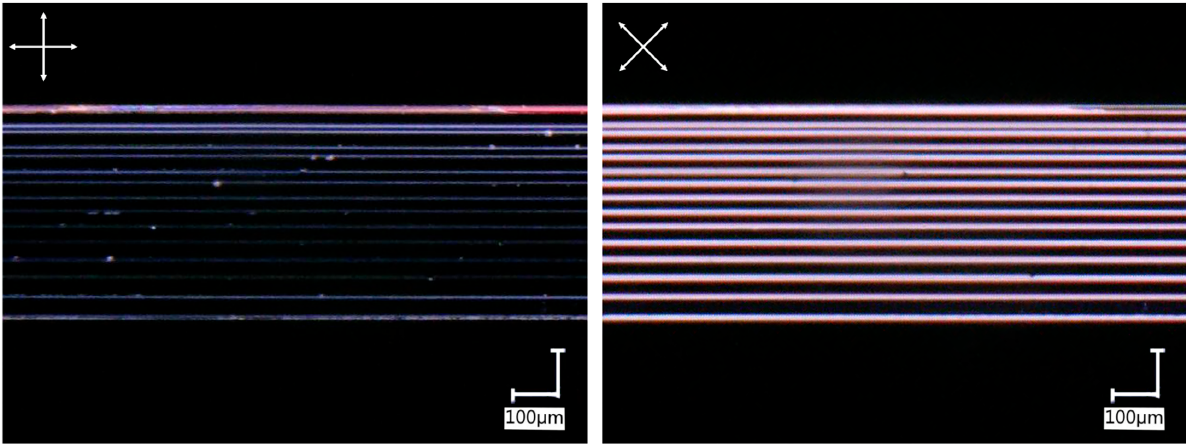
Figure 2. The PDMS:glass structure with microchannels of different widths (i.e., 10, 20, 25, 30, 35, 40, 45, and 50 µm, starting from the top of the photo) filled with E7 NLC and observed under the polarizing microscope (POM). The structure on the left is aligned with the polarizer axis, while the one on the right is rotated by an angle of about 45 degrees.